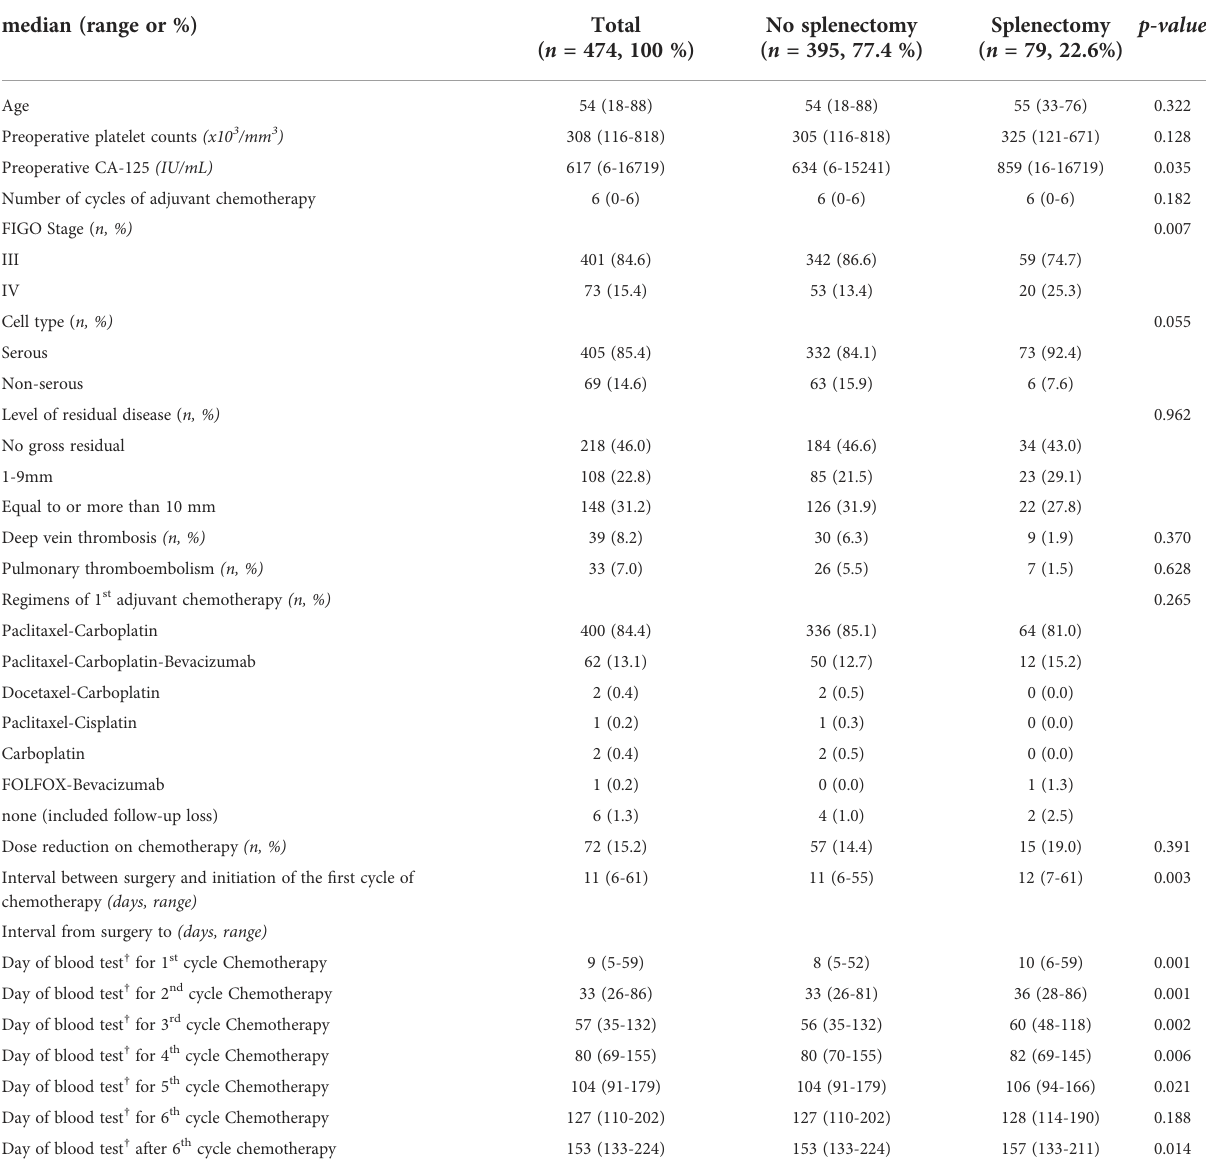
TABLE 1 Baseline patients ’ characteristics. median (range or